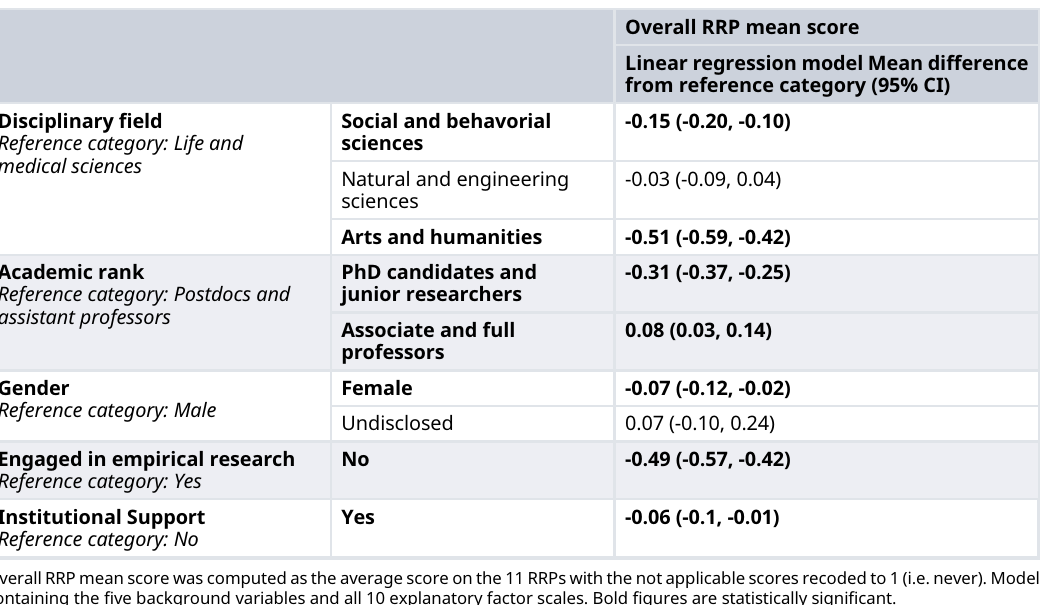
Table 2a. Linear regression coefficients (95% confidence interval) of overall RRP mean score stratified by background characteristics.